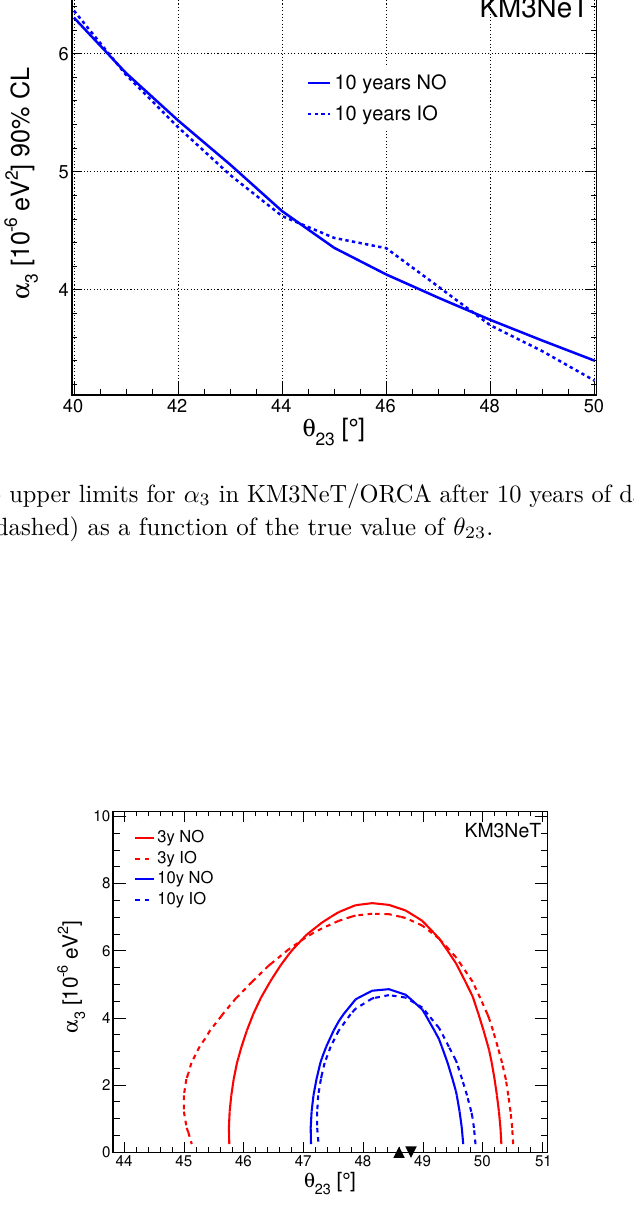
Figure 11. Contours in the θ 23 − α 3 plane at 90% CL for both NMO hypotheses for 3 (red) and 10 (blue) years of data taking. The true values used to simulate the Asimov dataset are marked with triangles, pointing up for NO and pointing down for